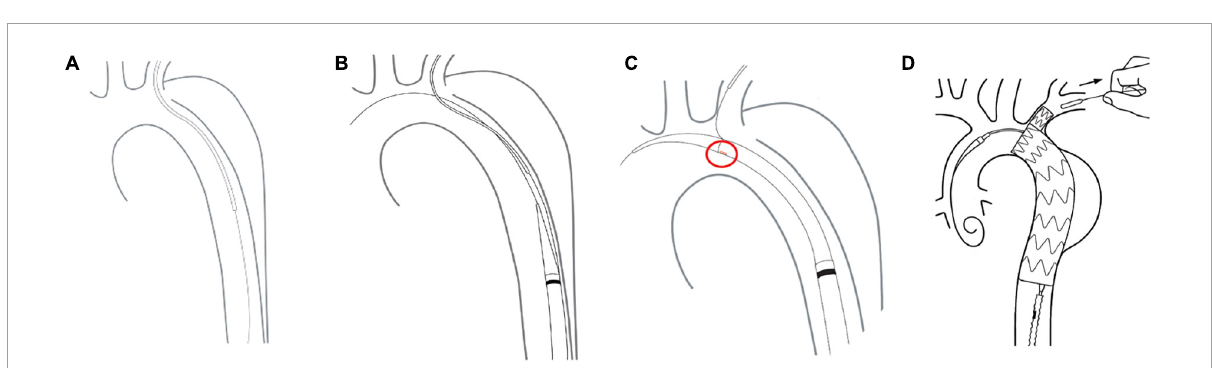
FIGURE2 Delivery and deployment of a Castor single-branched stent graft. (A) The guidewire is advanced from the femoral artery to the left brachial artery. (B) The delivery system is inserted into the descending aorta. (C) The correct position of the branch is assessed by the alignment of a marker band. (D) Stent